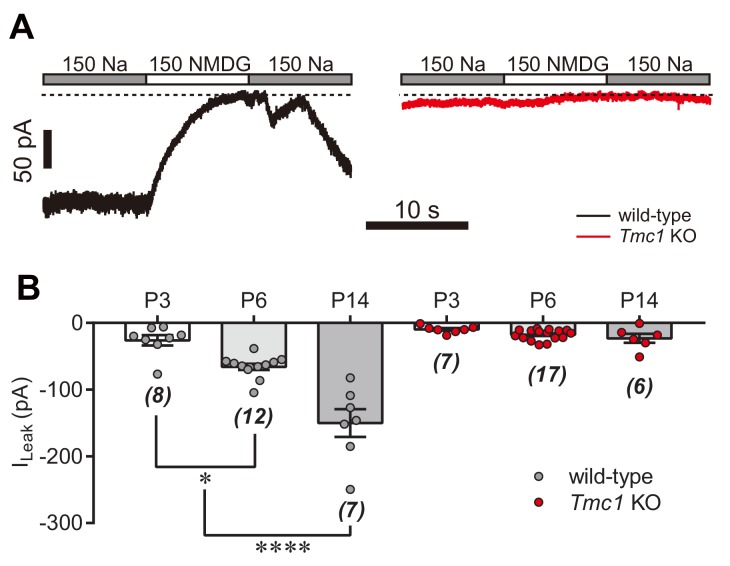
TMC1-dependent background leak current in ageing hair cells.(A) Representative Im traces in whole-cell voltage-clamp recorded OHCs from P14 wild-type and Tmc1-knockout mice. (B) Quantification of ILeak recorded from P3, P6, and P14 OHCs under conditions similar to those in (A). ILeak values (pA) for wild-type: P3, –26 ± 8; P6, –66 ± 5; P14, –150 ± 21. For Tmc1-knockout: P3, –10 ± 2; P6, –18 ± 2; P14, –23 ± 7. The holding potential was −70 mV. Data are presented as mean ± SEM and N values are shown in panel B. *p<0.05, **p<0.01, ***p<0.001, ANOVA.10.7554/eLife.47441.024Figure 8—figure supplement 1—source data 1.TMC1-dependent background leak current in ageing hair cells.